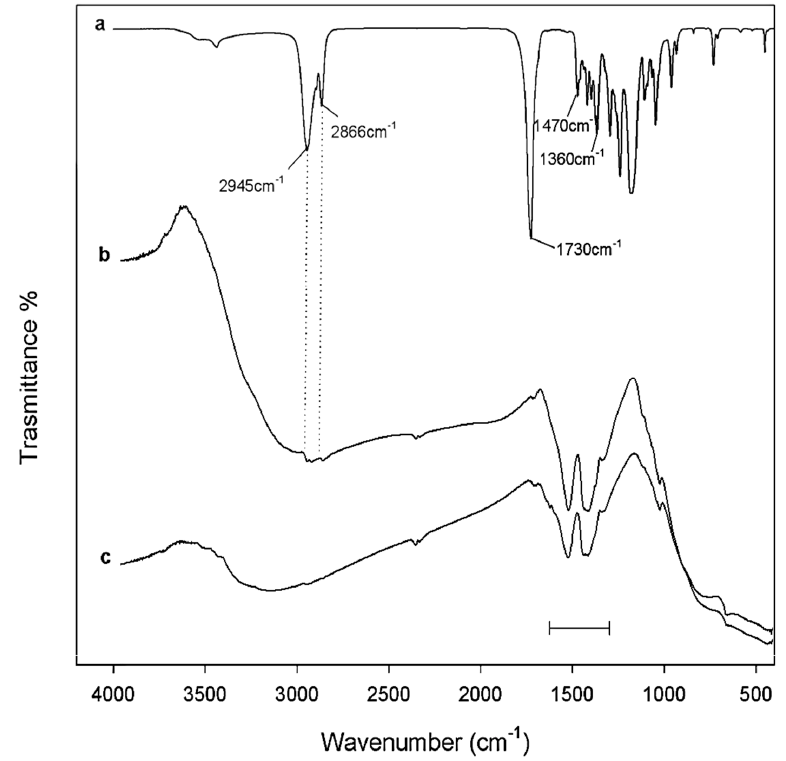
+ PCL 2 6 wt.% gel and ( c ) TiO 2